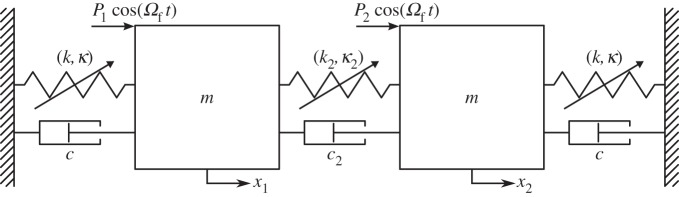
A schematic of an in-line, 2-d.f. oscillator with a symmetric structure. Identical cubic nonlinear springs, with linear spring constant k and cubic nonlinear constant κ, connect the masses to ground. Linear viscous dampers, with damping constant c, also ground the masses. Connecting the masses are a cubic nonlinear spring, with linear spring constant k2 and cubic nonlinear constant κ2, and a linear viscous damper, with damping constant c2. The displacements of the masses are written x1 and x2. Both masses are subjected to sinusoidal forcing at frequency Ωf and amplitudes P1 and P2 as shown.